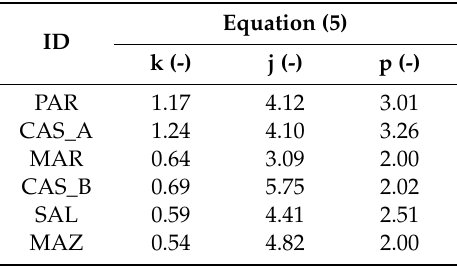
Table 3. Values of the parameters k, j, and p of Equation (5) for the di ff erent sites, obtained by considering both the examined bulk